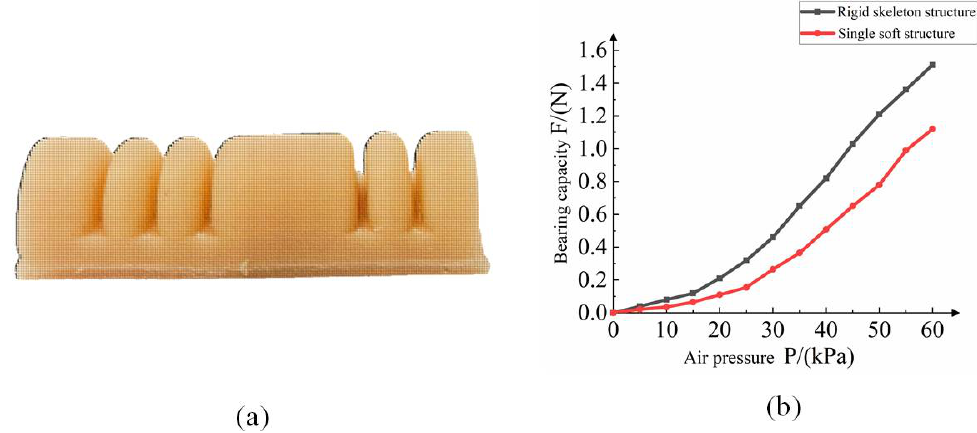
Figure 16. Comparison experiment of soft finger interphalangeal joint: ( a ) pure soft fingers, ( b ) test comparison.